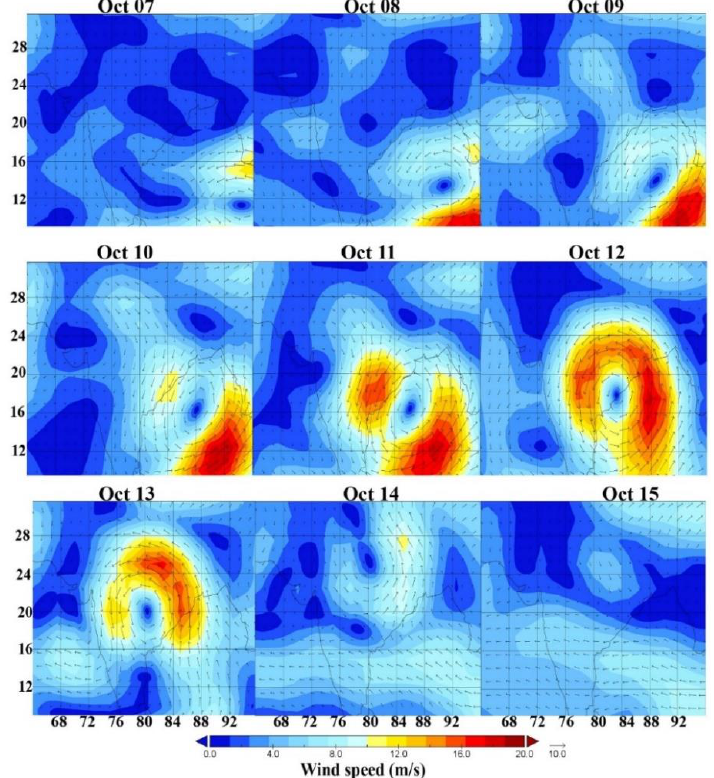
Figure 7. Wind speed and direction derived from NCEP/NCAR reanalysis data at the pressure level 700 hPa over India and the Bay of Bengal.